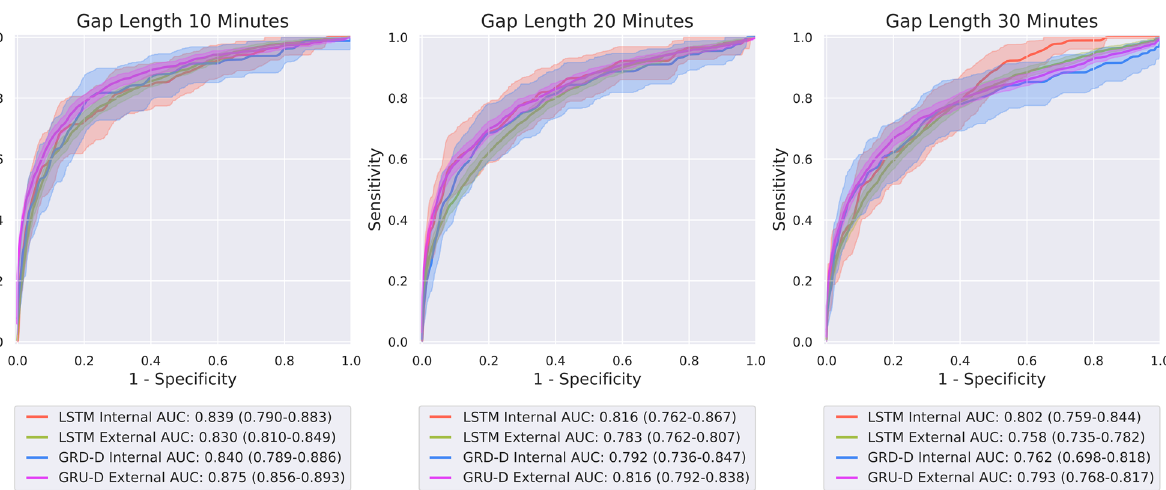
Figure 3. Comparison of AUROC between the logistic regression models, SVM models, and deep models on both the internal and external test sets at each investigated observation and gap length.